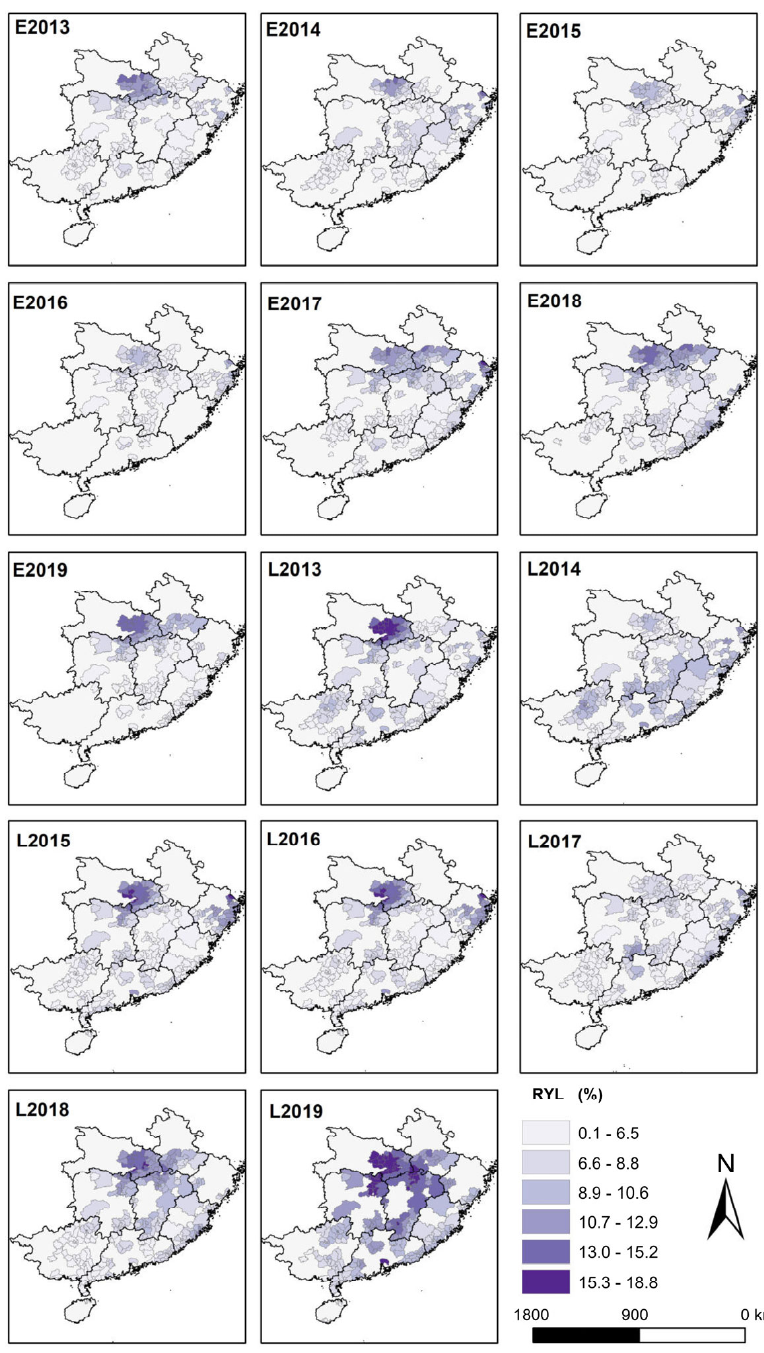
Figure 3. Spatial distribution of relative yield loss (RYL) of early rice and late rice over growing seasons from 2013 to 2019. The E and L in the part ‐ labels represent early rice and late rice, respectively.